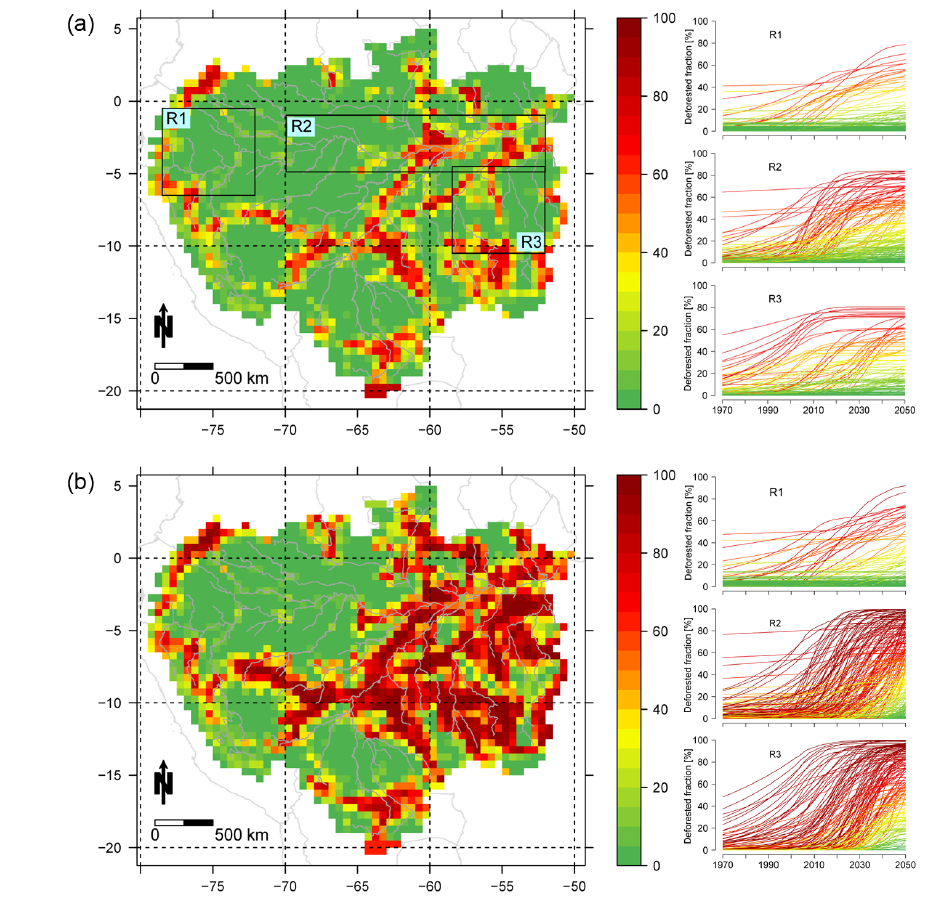
Figure 2. Fraction of deforested area per cell (%) in 2050. Data are based on Soares-Filho et al. (2006). (a) refers to the BAU deforestation scenario, whereas (b) refers to the GOV scenario. The three subregions discussed in the main text are highlighted in the map. The timelines (right panels) show the development until 2050 for each subregion (deforestation kept constant after